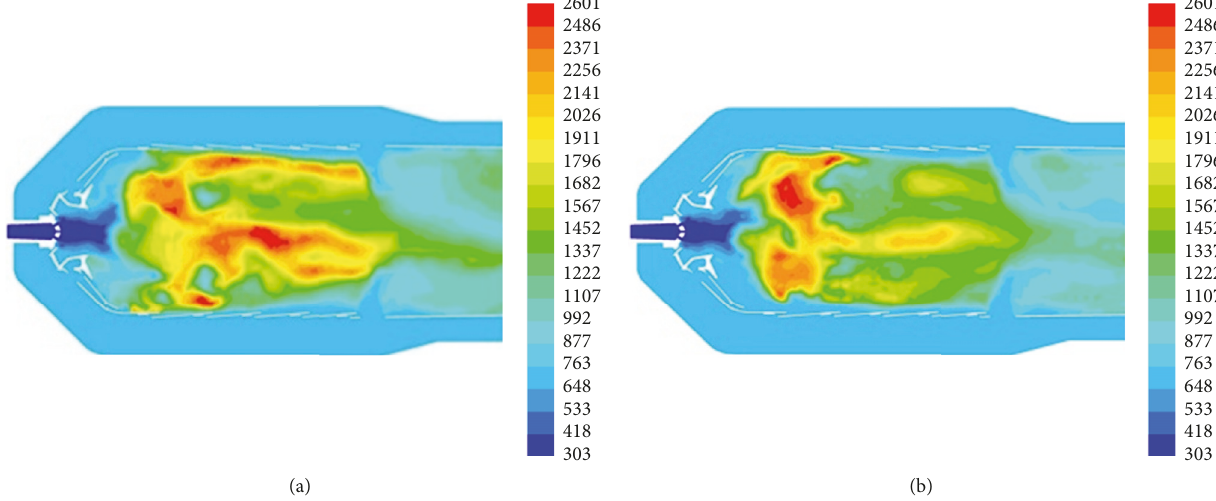
Figure 12: Temperature field in the longitudinal section of the combustor, K: (a) mechanism 1; (b) mechanism 2.